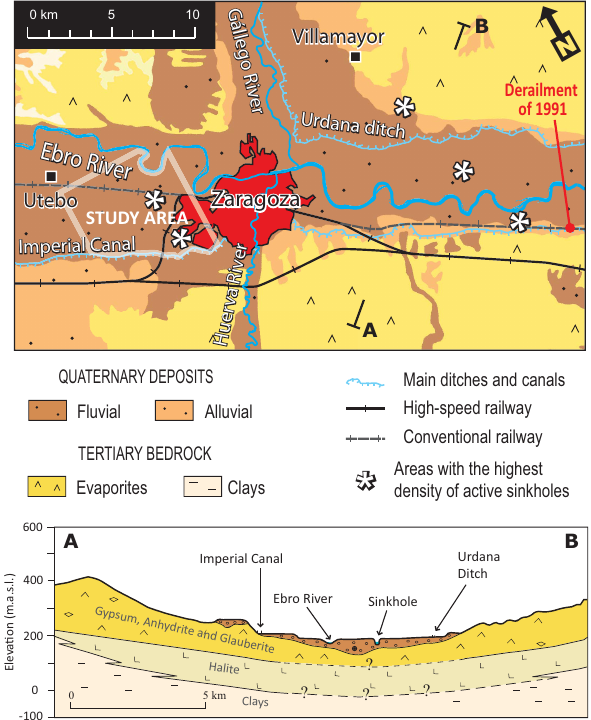
Figure 2. Geological map of the surroundings of Zaragoza and a geological cross section of the central sector of the Ebro Valley. From the geological point of view, the railway tracks crosses the central sector of the Ebro Cenozoic Basin and is underlain by sub- horizontally lying evaporites of the Oligo-Miocene Zaragoza Gyp- sum Formation (Quirantes, 1978). This formation is composed of gypsum, anhydrite, glauberite and halite units (Salvany et al., 2007). Sinkholes are caused by subsurface dissolution and the consequent deformation and/or internal erosion of the overlying sediments. De- tailed descriptions of the dissolution and subsidence processes in the study area can be found in Gutiérrez et al. (2008), Galve et al. (2009) and Acero et al.